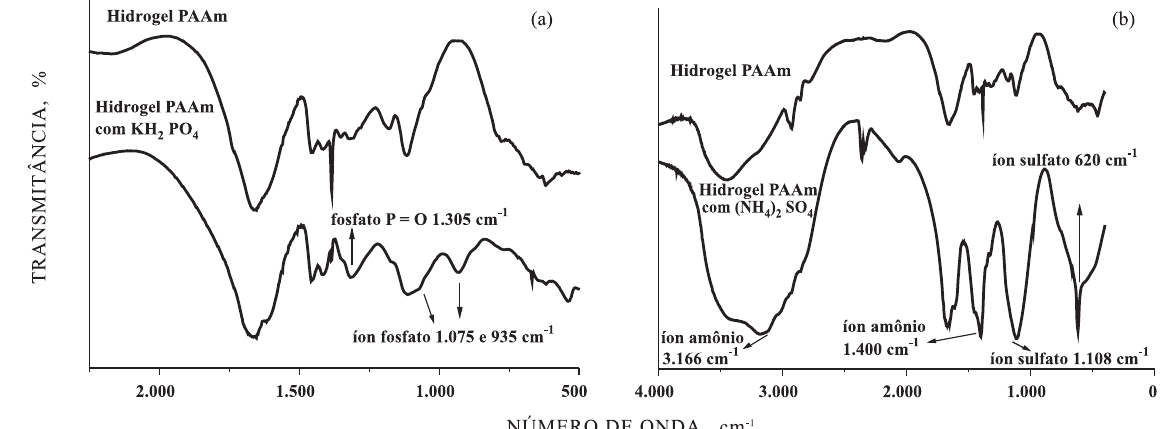
Figura 3. Espectros de FTIR dos hidrogéis de PAAm e PAAm com (a) KH